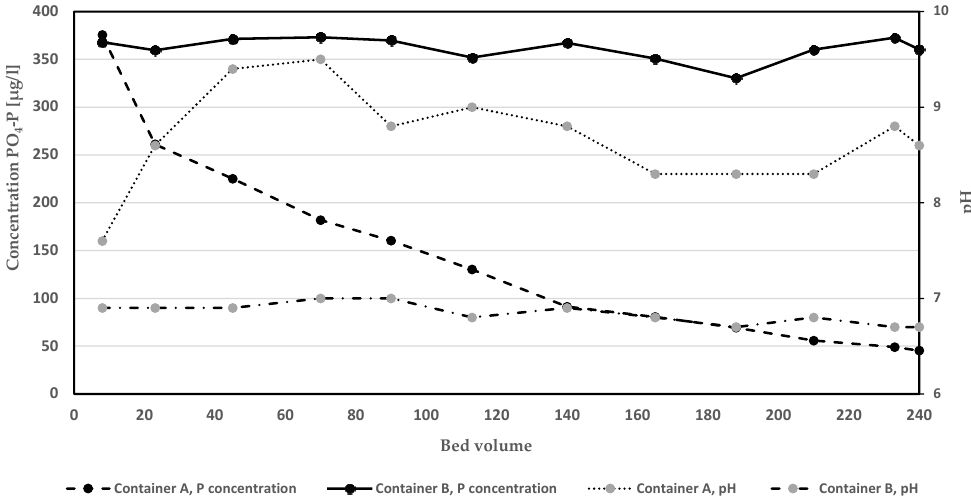
Figure 2. Development of PO4-P concentration and pH (presented as averages of a measurement in each of three water layers) in containers filled with hypolimnetic water and sediment. Water from container A circulated through filter with Polonite while container B water flowed through columns with glass beads.